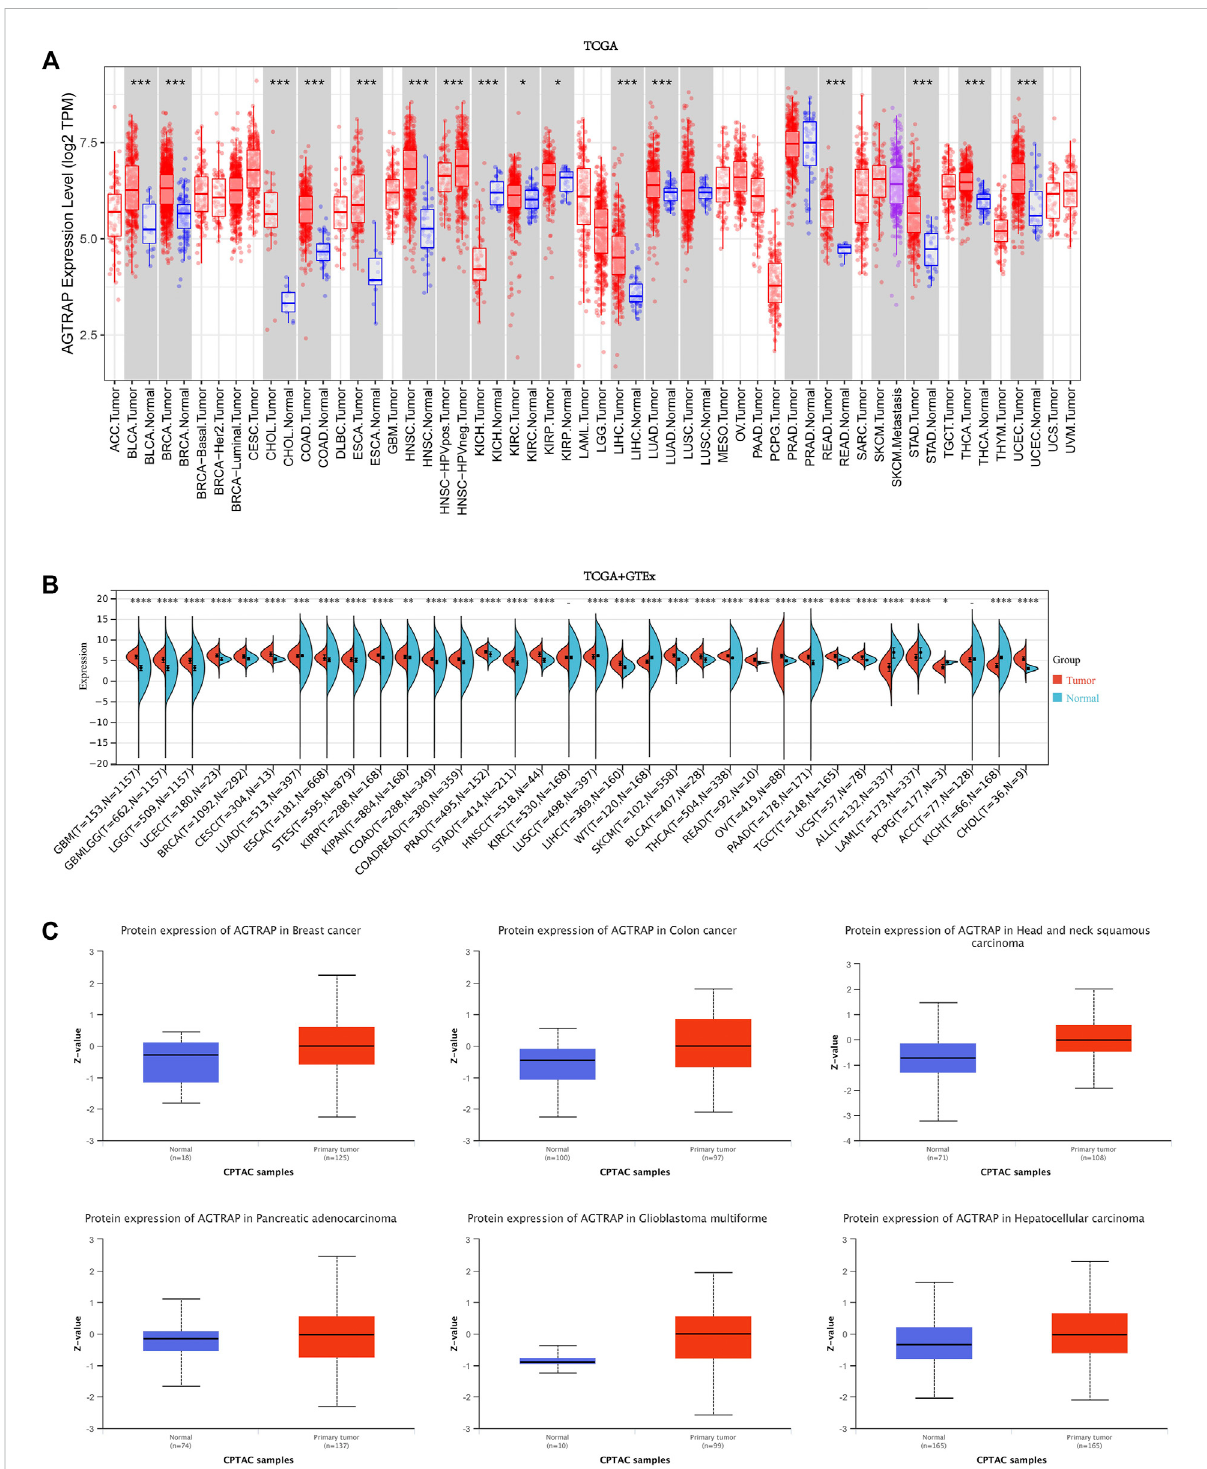
FIGURE 1 Expression and protein level of AGTRAP in pan-cancer. (A) mRNA expression levels of AGTRAP in different cancers from TCGA data in TIMER. * p < 0.05, ** p < 0.01, *** p < 0.001. (B) Analysisof TCGA and GTEx datasets showed differential mRNA expression of AGTRAP in various cancers. * p < 0.05, ** p < 0.01, *** p < 0.001. (C) AGTRAP protein expression level in pan-cancer from CPTAC samples. Z-values represented standard deviations from the median across samples for the given cancer